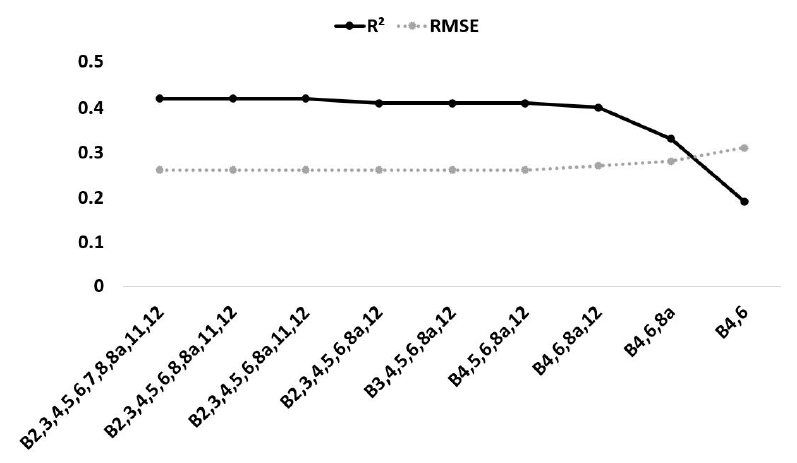
Figure 10. Best band to use for regression model.